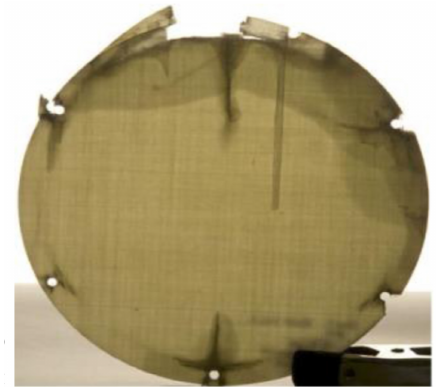
Figure 18. Material damage during test [13].